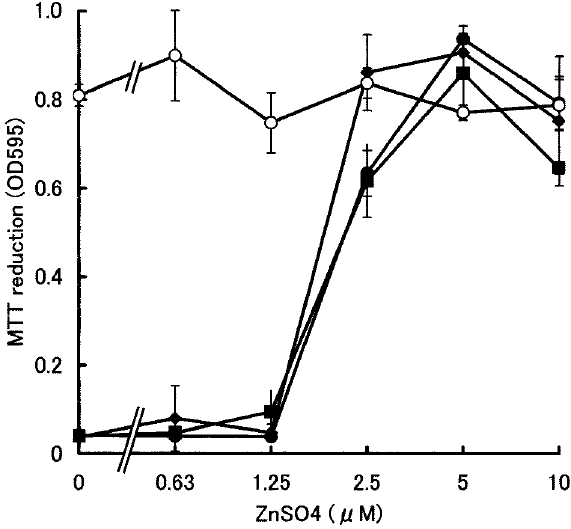
FIG. 6. Inhibitory effect of ZnSO 4 on apoptosis-inducing activity of rhMRP8/rhMRP14 complex, DTPA, or TPEN. EL-4 cells were cultured in divalent-cation-depleted medium ( s ) without, or ( d ) with rhMRP8/rhMRP14 complex (2.5 m M), with ( j ) DTPA (2.5 m M) or ( © ) with TPEN (2.5 m M) for 48h in the absence or presence of the indicated concentrations of ZnSO 4